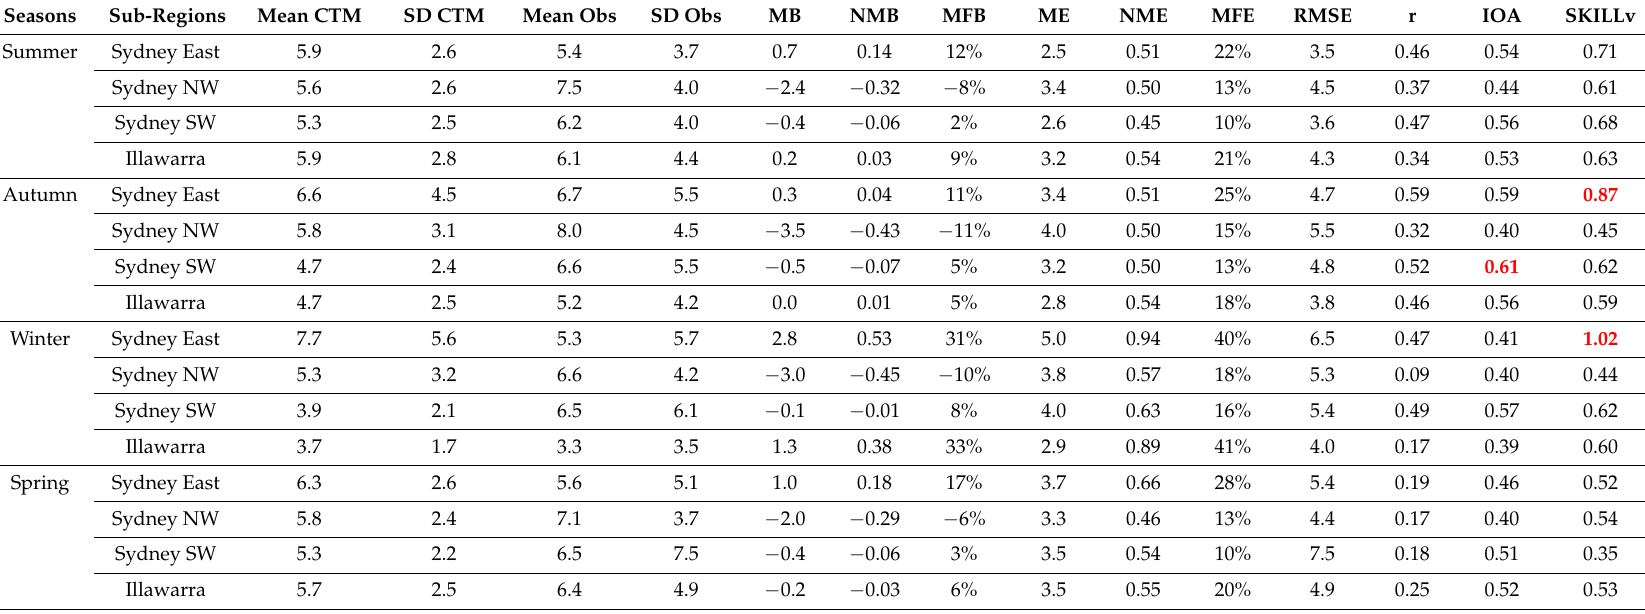
Table 2. Quantitative performance statistics for predicted hourly PM 2.5 concentration ( µ g/m 3 ) against observations for regions by